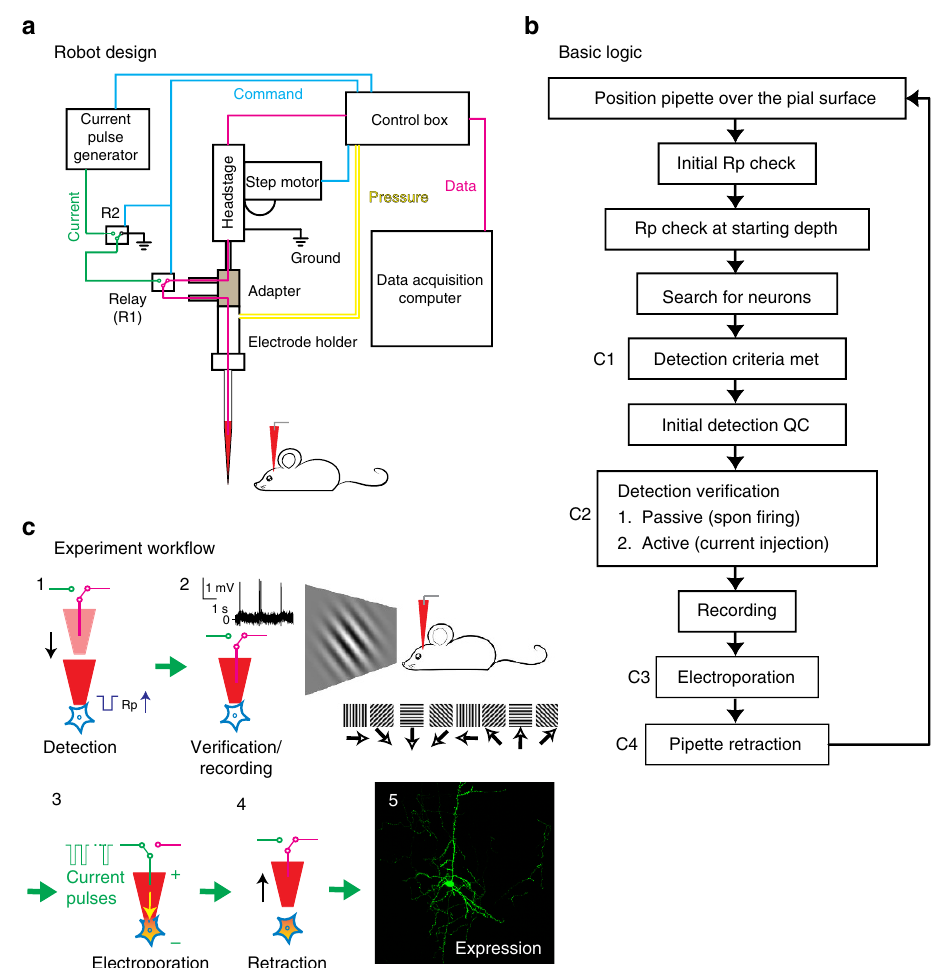
Figure 1 | Automating in vivo single-cell recording and perturbation. ( a ) Schema of ACE design showing major hardware components of ACE, the Automatic single-Cell Experimenter. The relay-based mechanism allows freely switching between single-cell recording and perturbation (electroporation). ( b ) Block diagram illustrating the basic logic flow of ACE operations for pipette advancement, neuron detection and verification, neural activity recording and electroporation. For detailed information see Methods section. ( c ) Illustration of main steps of representative experiment work-flow for in vivo single-cell recording/labelling experiments to study the structure–function relationship in single neurons. These steps are labelled in b